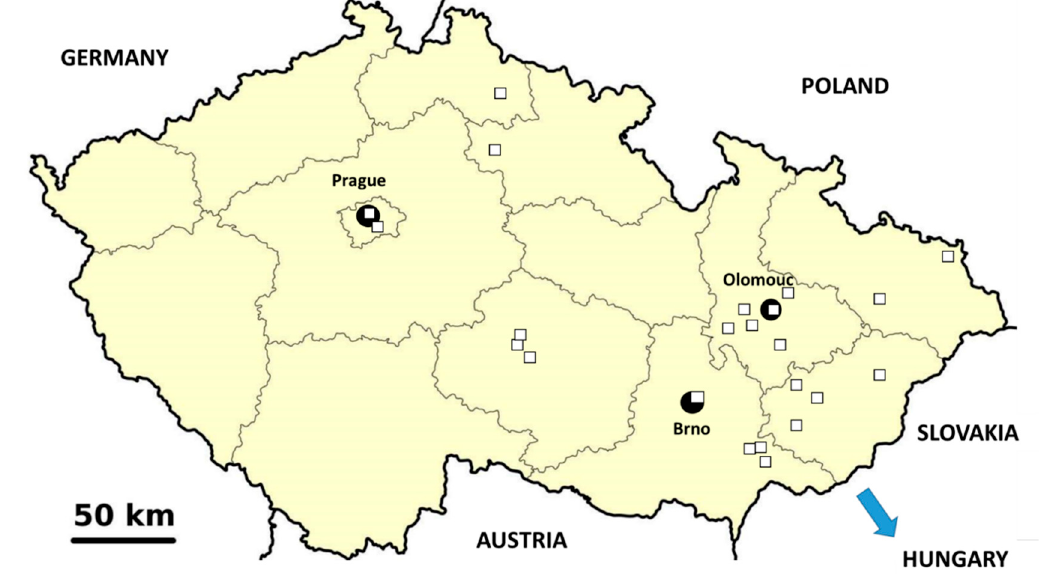
Figure 1. Map of the locations in the Czech Republic where the samples of powdery mildew infection on trees and shrubs are collected, and boundaries of neighbouring countries.